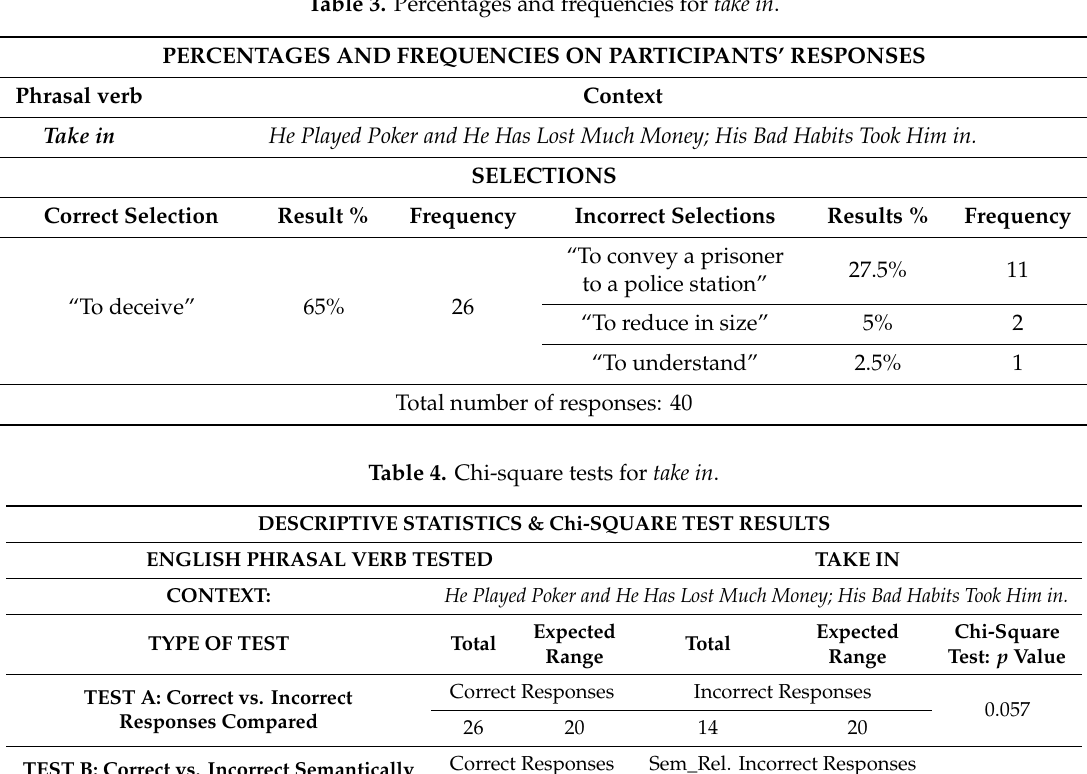
Table 3. Percentages and frequencies for take in .